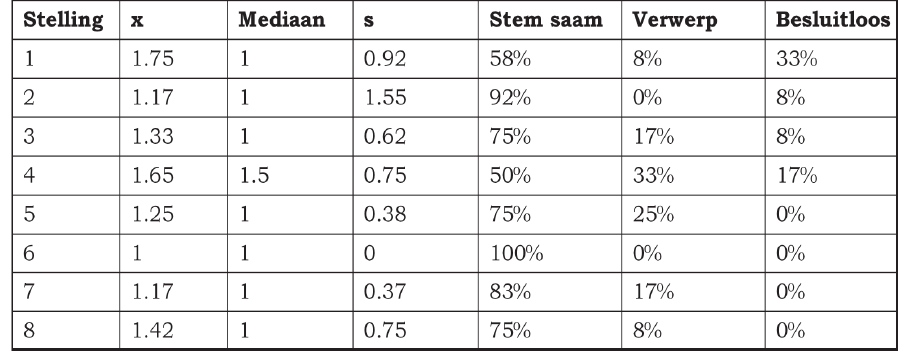
TABEL 2: Stellings oor geïntegreerde bemarkingskommunikasie